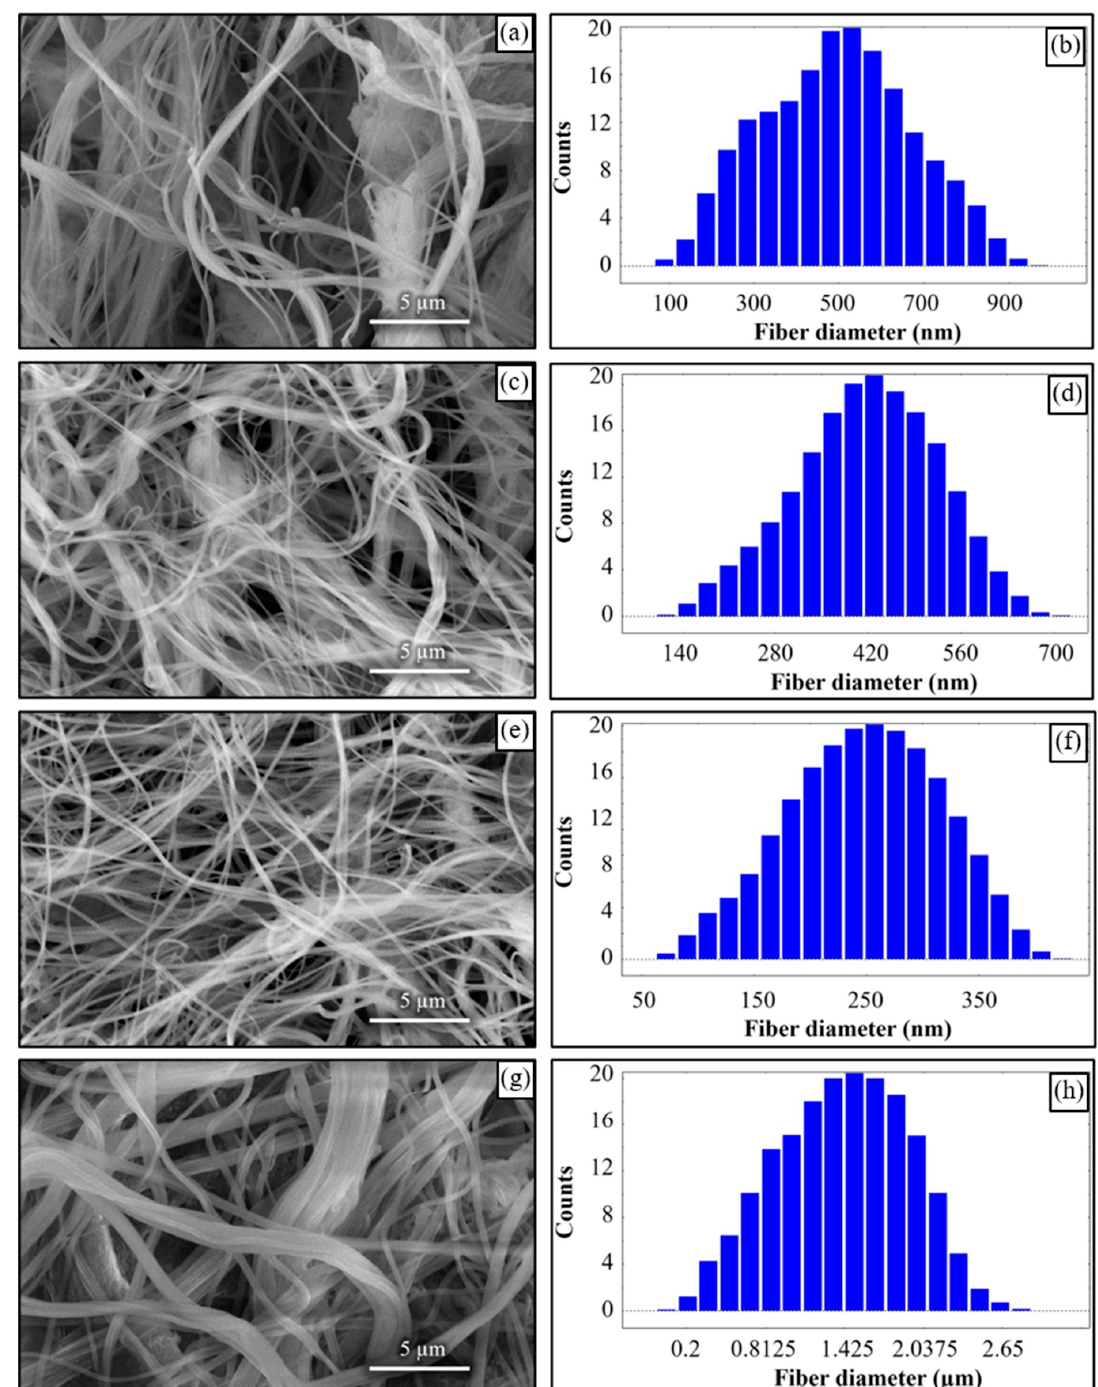
Figure 14. ( a , c , e , g ) SEM results at 2,3,4, and 5 bar air pressures, and ( b , d , f , h ) their respective fibre size